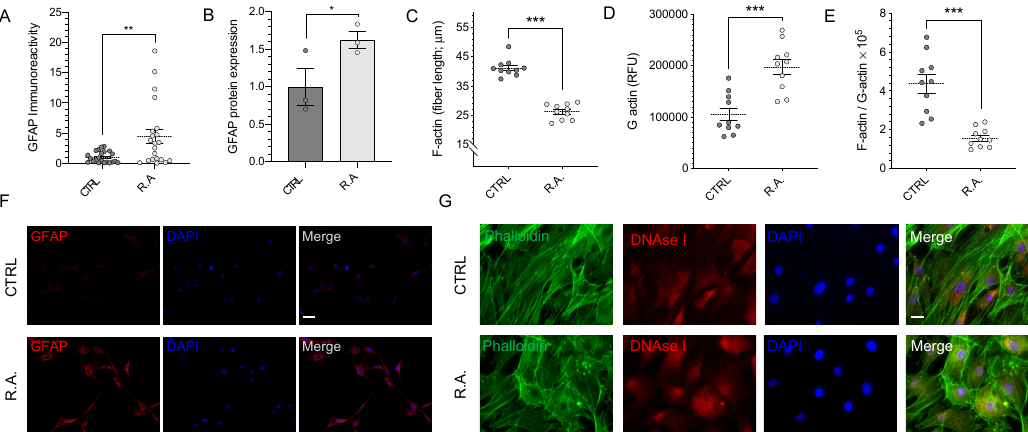
Figure 1. Reactive astrocytosis results in cytoskeletal remodeling. ( A ) anti-glial fibrillary acid protein (GFAP) immunoreactivity was quantified by fluorimetry. A statistically significant increase in GFAP immunoreactivity was observed in activated astrocytes compared to control ( n = 20–21; p < 0.01). ( B ) Quantitative immunoblot analysis revealed a statistically significant increase in GFAP protein expression in activated astrocytes ( n = 3; p < 0.05). ( C ) Quantification of individual F-actin fiber lengths revealed a statistically significant 36% ± 2% decrease in activated optic nerve head astrocytes ( n = 10; p < 0.001). ( D ) A statistically significant 87% ± 12% increase in G-actin immunofluorescence was observed in activated astrocytes ( n = 10; p < 0.001). ( E ) The F-actin to G-actin ratio showed a statistically significant decrease in activated astrocytes ( n = 10, p < 0.001). ( F ) Representative images of GFAP immunocytochemistry. ( G ) Representative images of actin staining. Oligomeric F-actin and monomeric G-actin were visualized using ActinGreen TM ReadyProbes TM Reagent and Alexa Fluor TM 594 conjugated DNAseI, respectively. Data were analyzed by Student’s t -test; * p < 0.05, ** p < 0.01, *** p < 0.001. Scale bar: ( F ) 25 μ m, ( G ) 10 μ m. CTRL = control; R.A. = reactive astrocytosis.